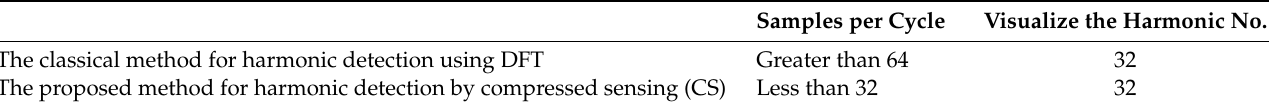
Table 1. Differences in harmonic detection between DFT and CS. Samples per Cycle Visualize the Harmonic